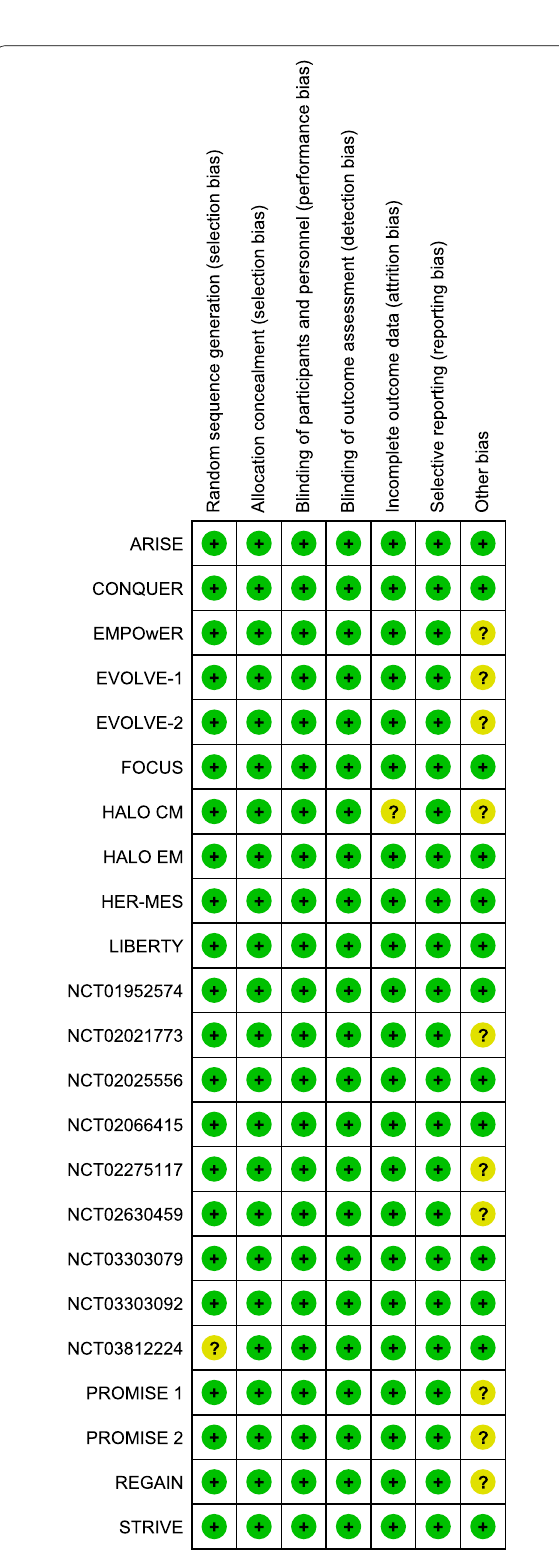
Fig. 2 Risk of bias summary for each included